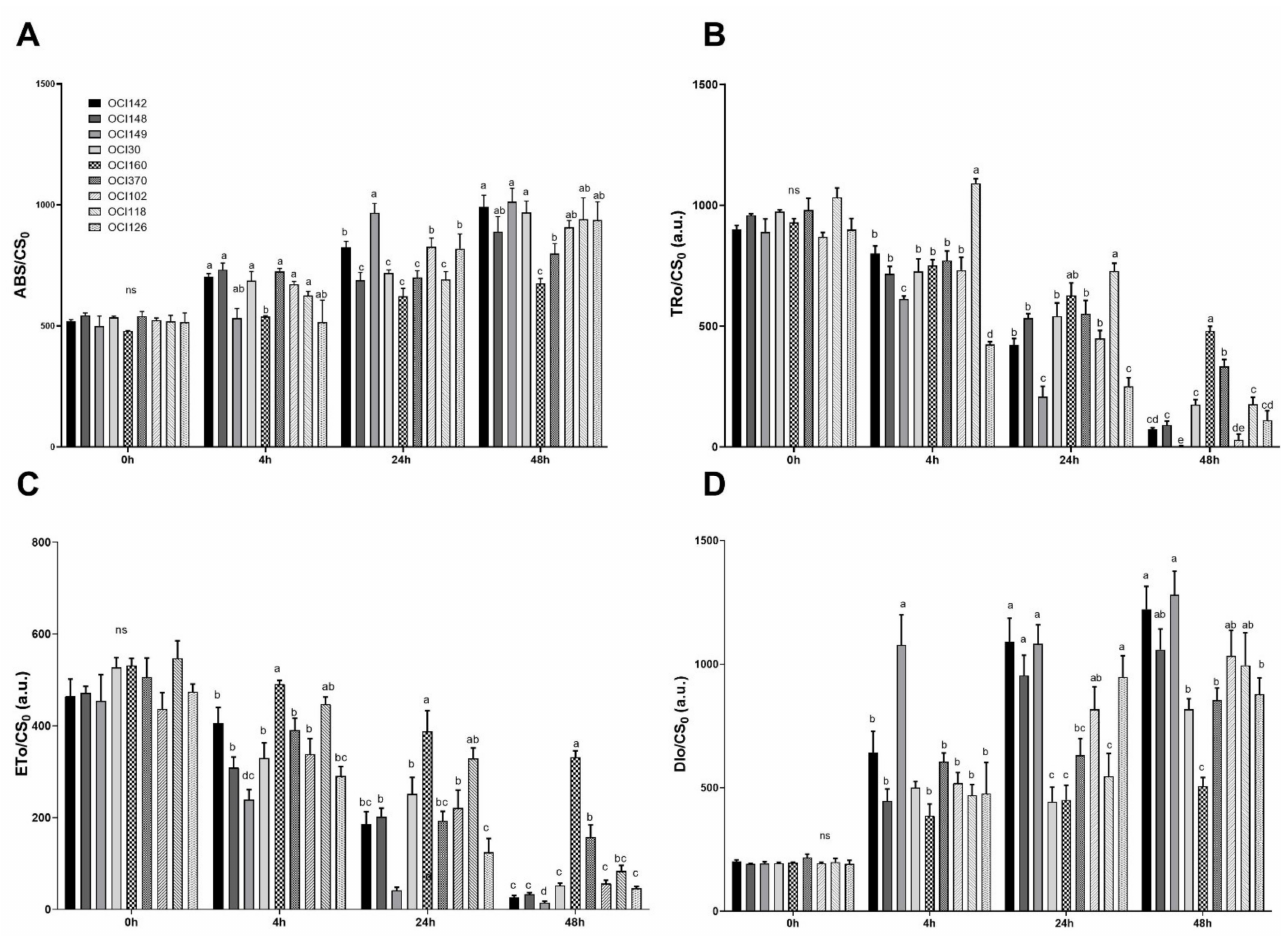
Figure 3. Time course of chlorophyll a fluorescence parameters measured in leaves of nine different sweet basil ecotypes exposed to UV-B light (68 kJ m − 2 day − 1 ) or not exposed (ctrl). ( A ) Absorption flux per cross section, ABS/CS 0 ; ( B ) Trapped energy per cross section, TRo/CS 0 ; ( C ) Electron transport flux per cross section, ETo/CS 0 ; ( D ) Dissipation energy per cross section, DIo/CS 0 . Data are shown as means with at least five independent biological replicates. The measurements were carried out at 0, 4 h, 24 h, and 48 h after the end of the UV-B exposure. Values are means with standard errors (n = 5) and error bars indicate standard error. Data were subjected to the analysis of variance and differences were analyzed by Tukey’s posttest. Different letters within the time denote significant differences at p <